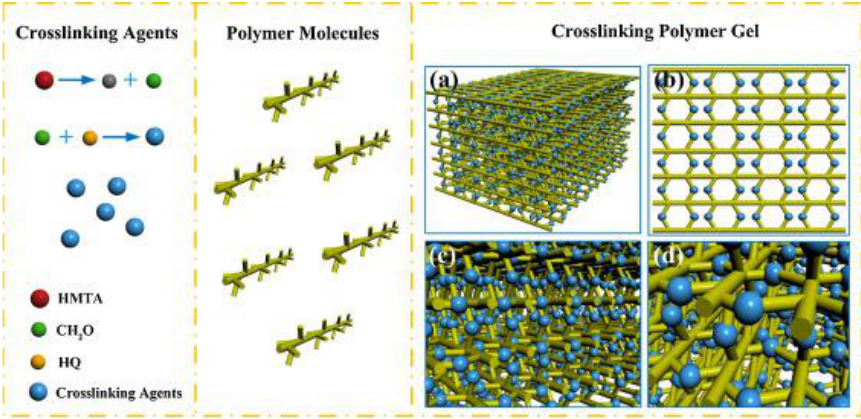
Figure 1. Schematic diagram showing the crosslinking mechanism of the resorcinol/HMTA gel. ( a – d ) Three-dimensional network structure of gels from different perspectives. (Reprinted/adapted with permission from Ref. [28]. 2016, Liu, et